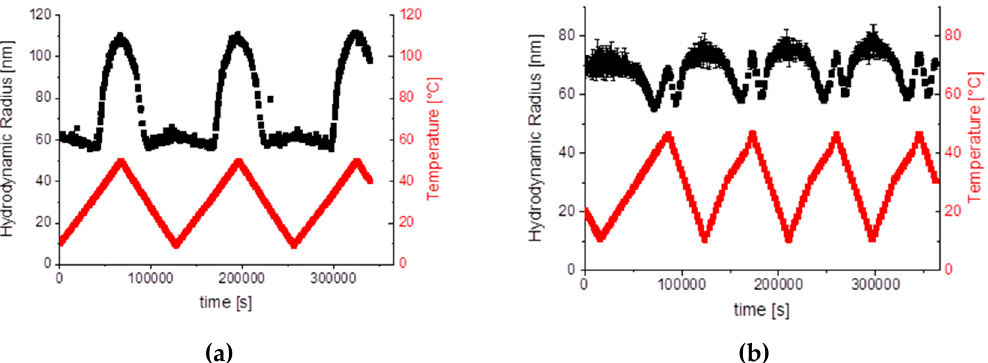
Figure 7. Hydrodynamic radius for several heating and cooling cycles for sample SiPN-2 ( a ) and SiPN-3c ( b ).